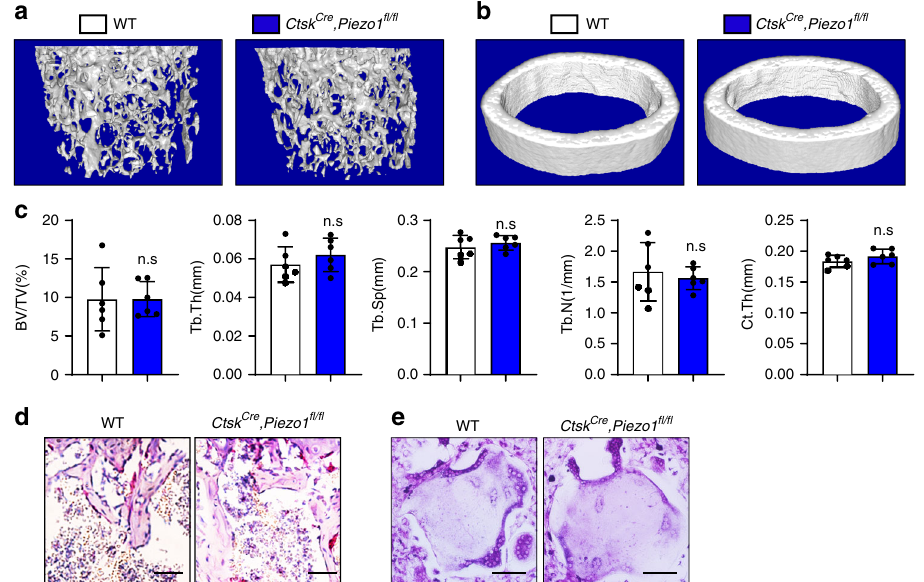
Fig. 3 Piezo1 de fi ciency in osteoclasts did not affect the bone formation. a , b 3D μ -CT images of trabecular bones ( a ) and cortical bones ( b ) of distal femurs isolated from 6-week-old female WT and Ctsk Cre , Piezo1 fl / fl mice. c μ -CT analysis of distal femurs from 6-weeks-old female WT and Ctsk Cre , Piezo1 fl / fl mice for bone volume per tissue volume (BV/TV), trabecular thickness (Tb.Th), trabecular number (Tb.N), trabecular spacing (Tb.Sp) and cortical thickness (Ct.Th) of middle shaft of femurs. * P < 0.05; ** P < 0.01. Two-tailed Student ’ s t test. Data are mean ± SD, n = 6. d TRAP staining of femurs isolated from 6-week-old WT and Ctsk Cre , Piezo1 fl / fl mice. e TRAP staining of osteoclasts differentiated from bone marrow monocytes isolated from WT and Ctsk Cre , Piezo1 fl / fl mice. Scale bar = 100 μ m. Source data are provided in the Source Data